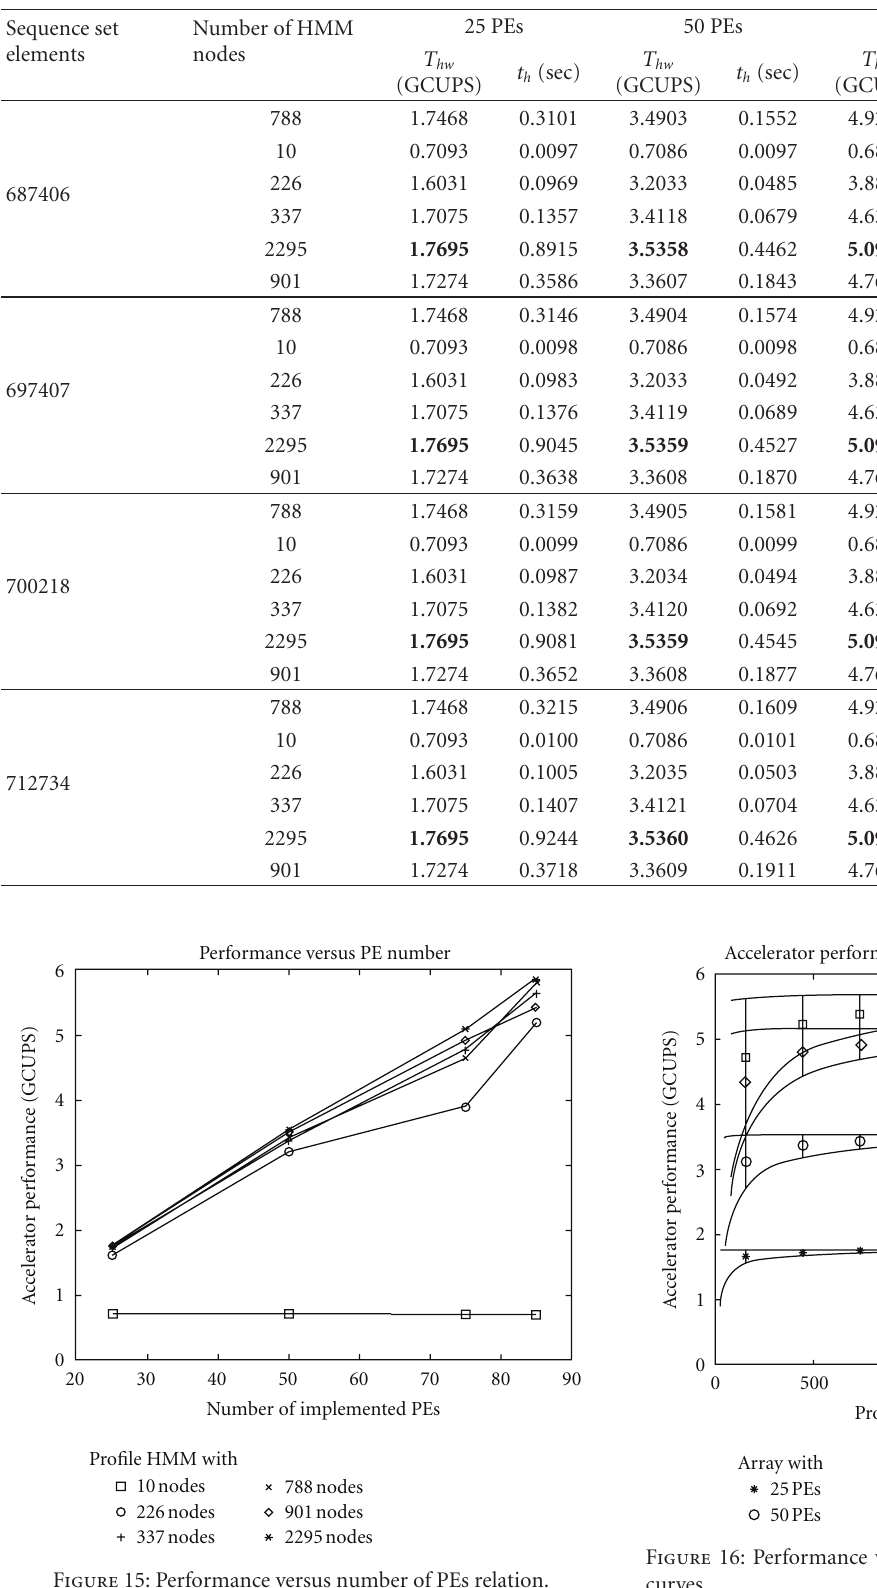
Table 5: Hardware performance results.